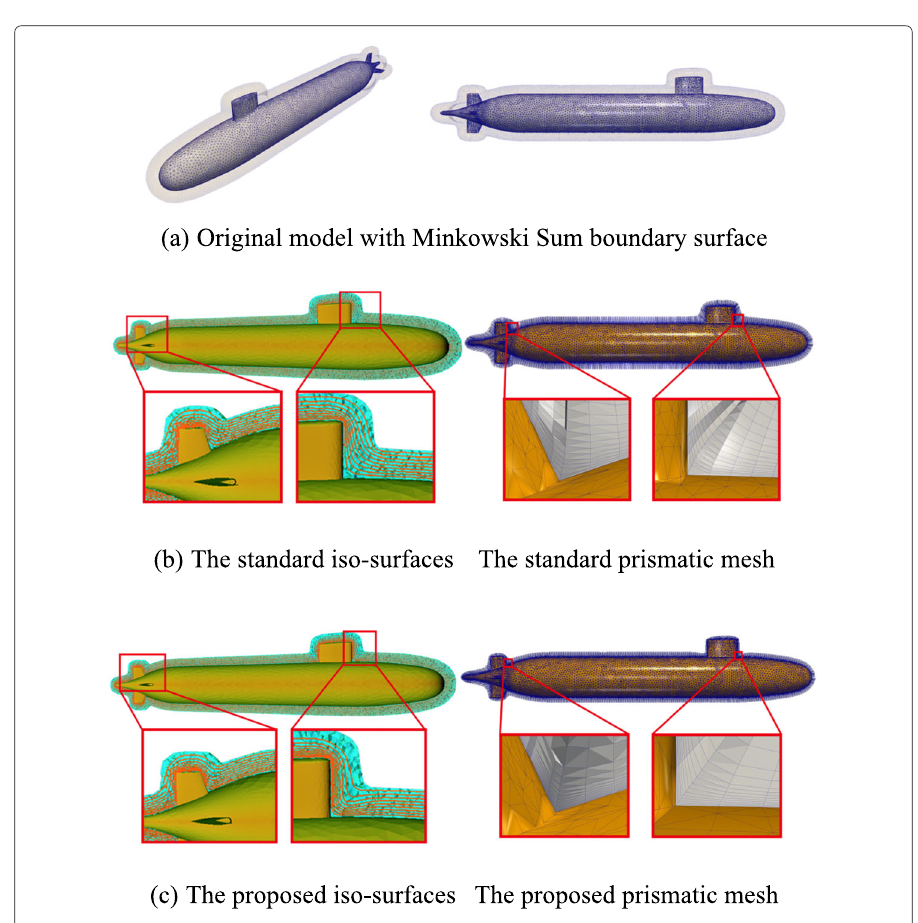
Fig. 6 Prismatic mesh of submarine model. ( a ) The original surface and envelope surface; ( b ) and ( c ) The iso-surfaces and prismatic meshes generated using the standard harmonic field and the proposed anisotropic harmonic field,